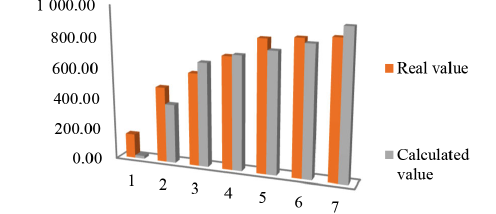
Figure 3. Real value of the volume of produced Alw , versus calculated